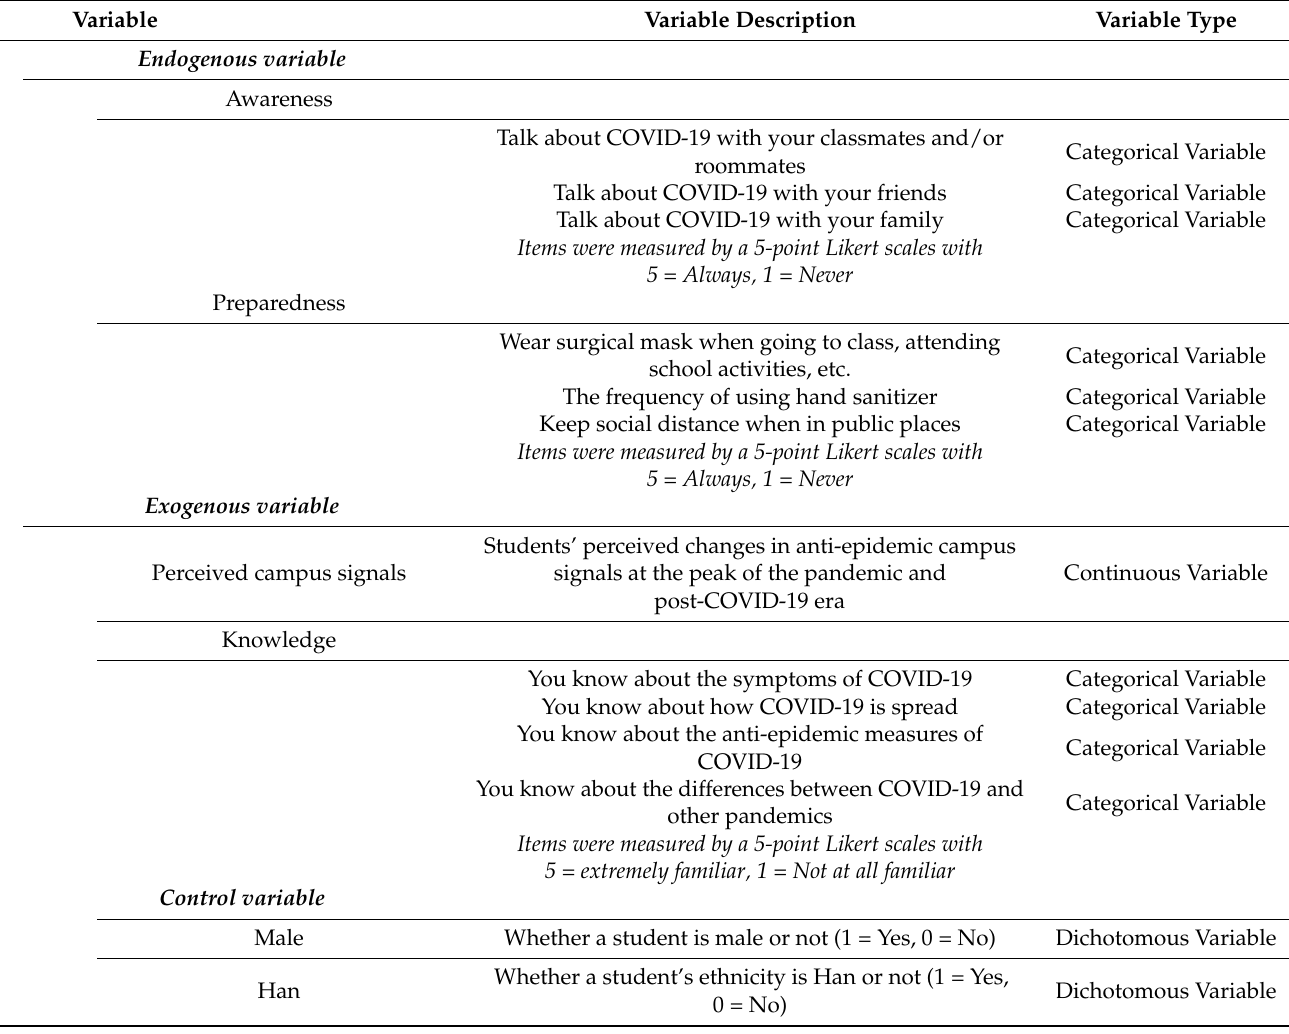
Table 1. Description of